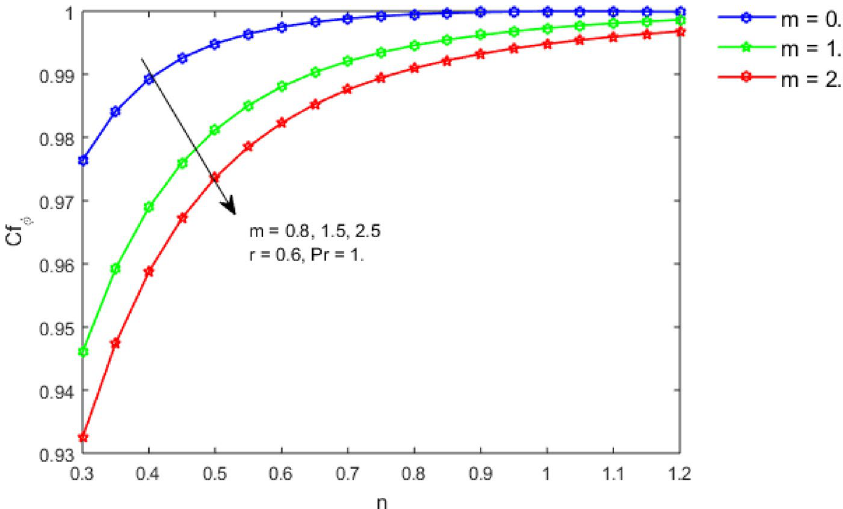
Figure 18. Coefficient of drag force in tangential direction by increasing m , for n < 1, n = 1 and n > 1 .